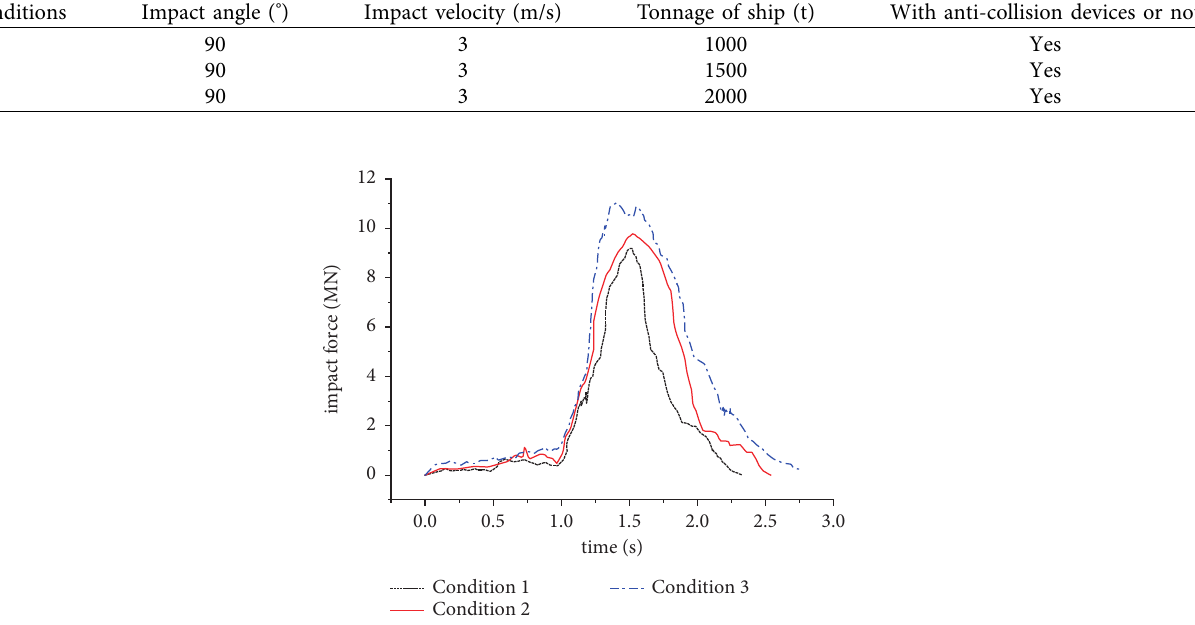
Figure 9: Time of impact force of different ship weights on bridge piers with protective devices. Table 4: Working conditions of ship impact at different speeds.